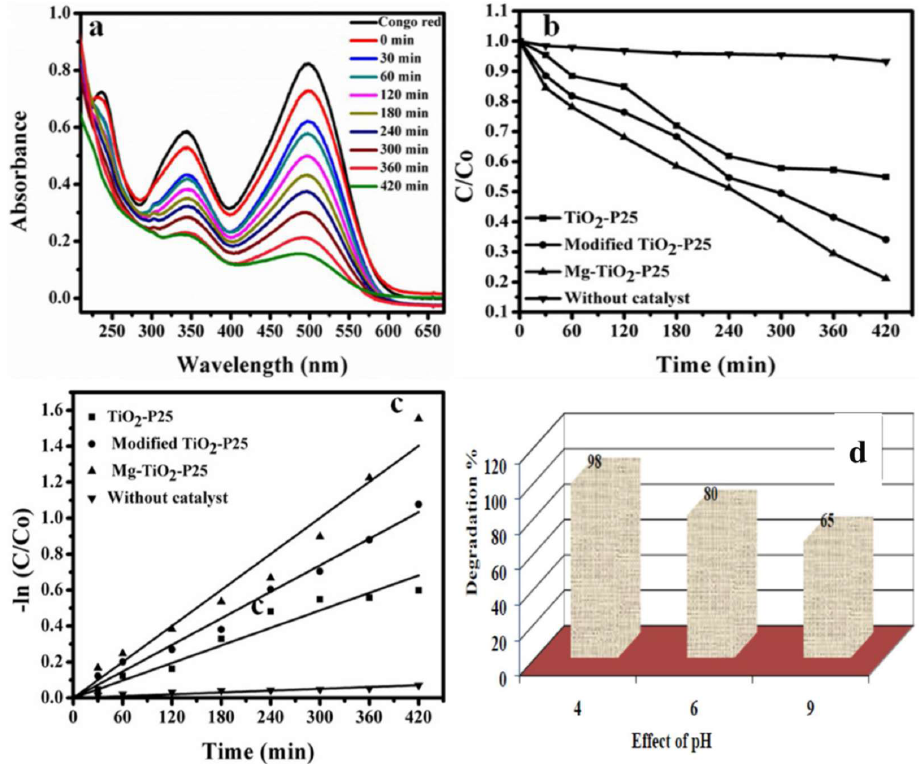
Figure 6. ( a ) Time-dependent UV–Vis absorption spectrum of Mg-TiO 2 -P25 nanoparticles in the presence of persistent Congo red dye under illumination. ( b ) Photocatalytic degradation curve for different catalysts in the presence of Congo red. ( c ) First-order plot for the degradation of Congo red (2.5 × 10-5, 50 mg Mg-TiO 2 -P25 nanoparticles). ( d ) Effects of the variation of catalyst pH on photocatalysis. Adapted from reference [113]. The photocatalytic rate of MO dye is only 10.0% at pH = 6.4, 54.5% at pH = 4, and 93.2% at pH = 2. It can be observed that photodegradation efficacy diminishes with in- creasing pH for (TiO 2 /PW12)10. The (TiO 2 /PW12)10 shows the maximum photocatalytic